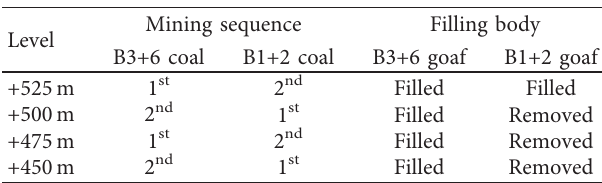
Figure 3: The physical model of similar Table 2: The mining process.